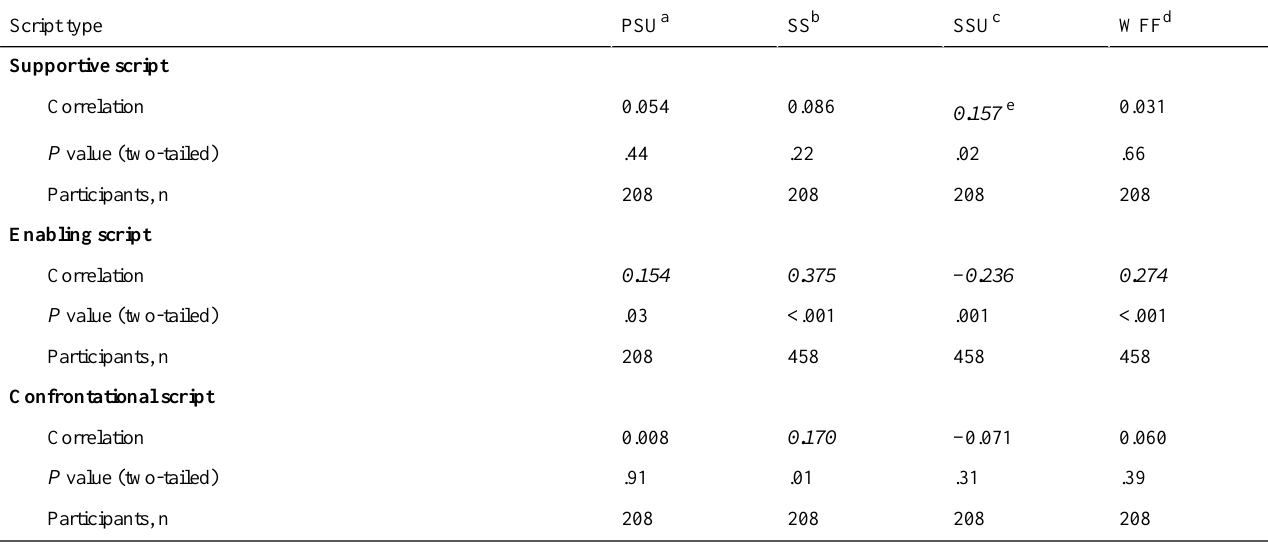
Table 3. Script ratings and Significant Other Behavior Questionnaire subscale